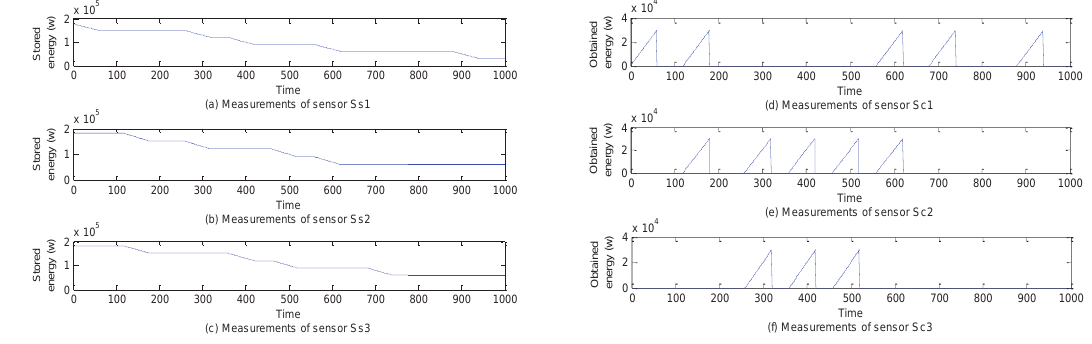
Figure 11. Measurements from sensors under the normal situation of scenario